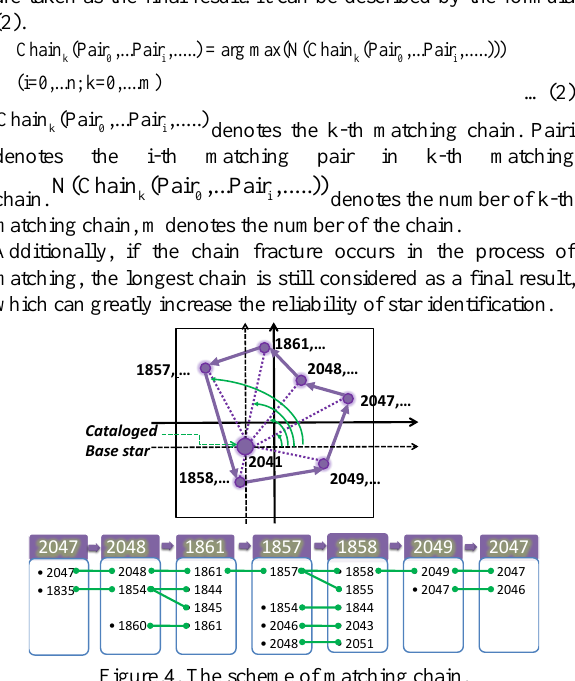
Figure.4. The scheme of matching chain.